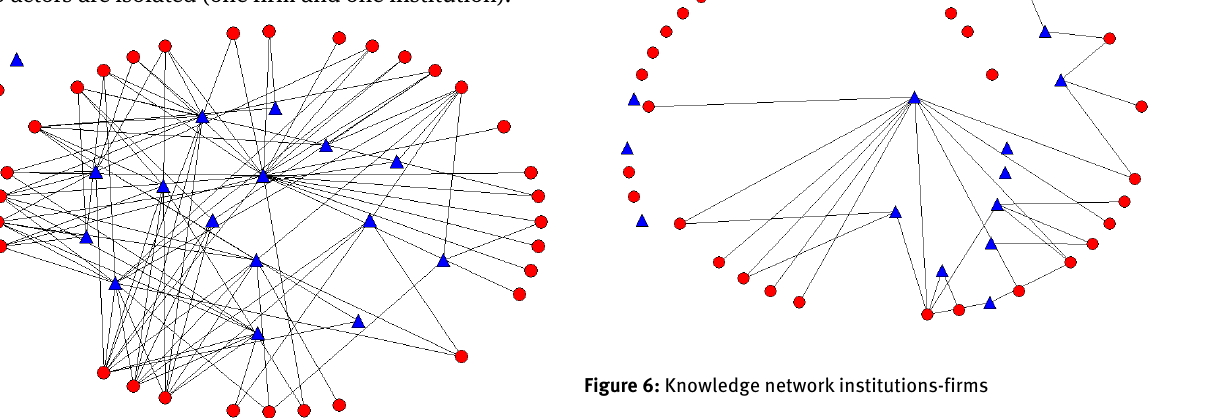
density drops to 2.48% and the inclusiveness to 52%. As expected, the graph is highly disconnected, as the number